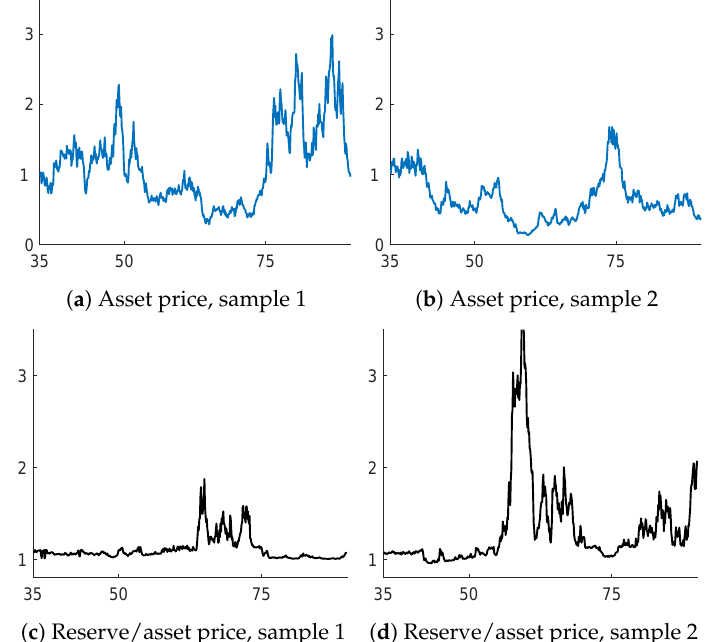
Figure 10. Asset price paths and excess ratio of associated GMDB